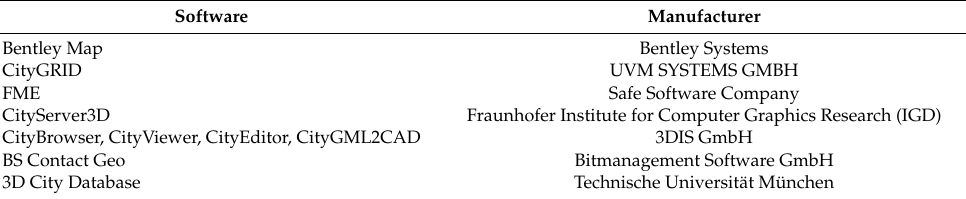
Table 2. Common software used in order to manage CityGML data.